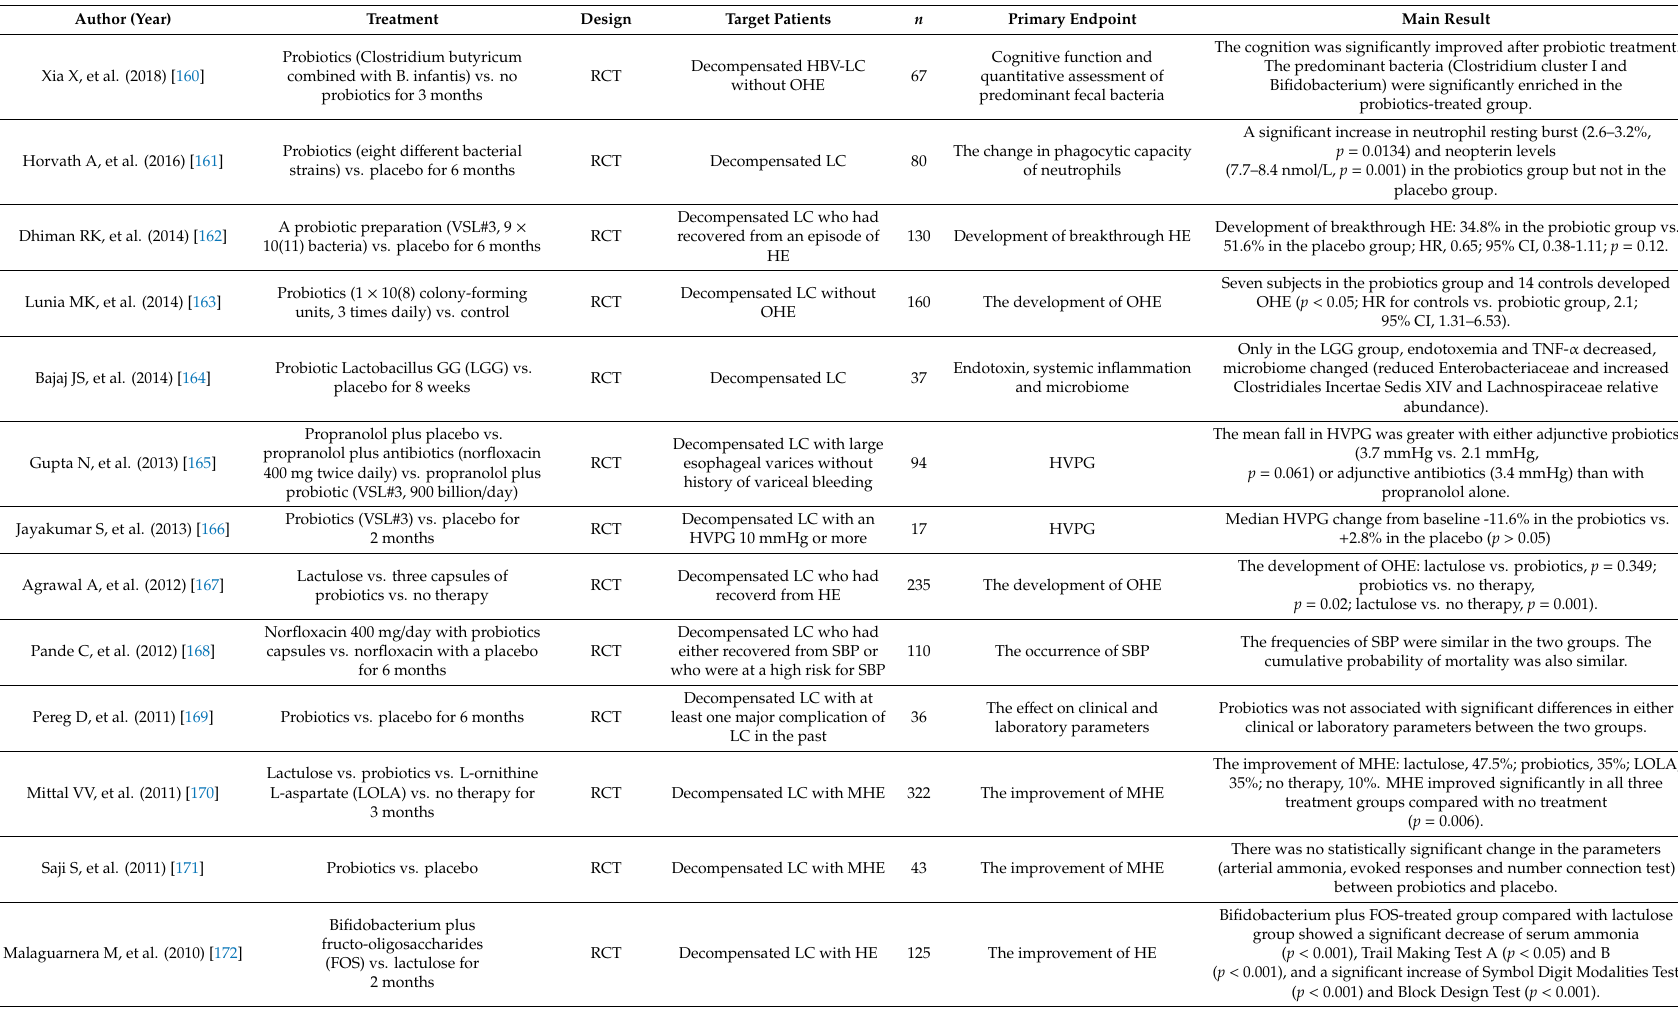
Table 3. Randomized controlled trials published since 2010 regarding the e ff ect of probiotics in patients with decompensated liver cirrhosis. MHE: minimal hepatic encephalopathy; OHE: overt hepatic